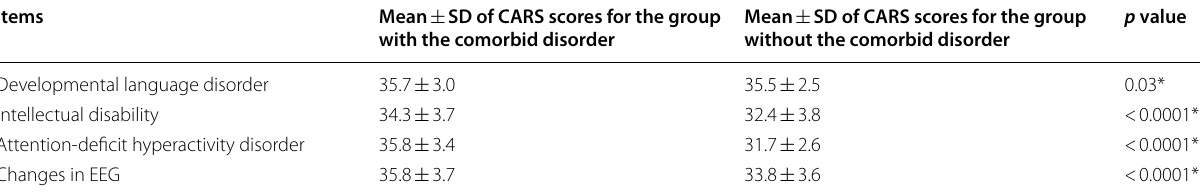
Table 1 The influence of comorbidities on the childhood autism rating scale scores in autistic children with and without